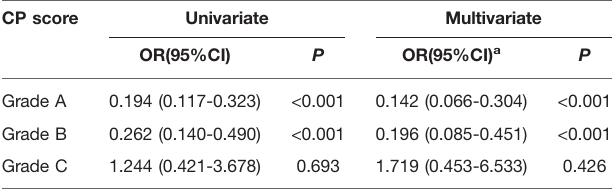
TABLE 4 | Subgroup analysis of the association between primary prophylaxis and